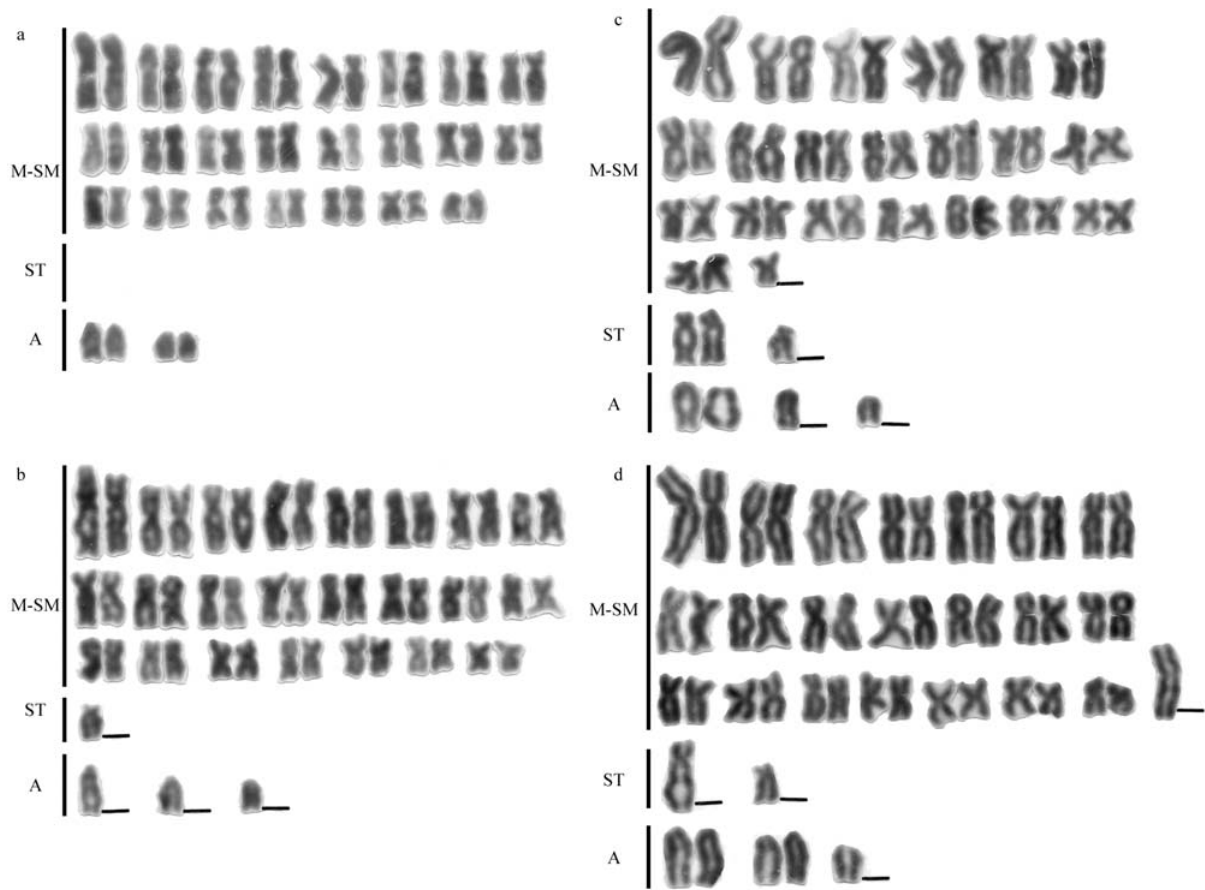
Figure2 -KaryotypesofPratariver Hoplerythrinusunitaeniatus with2n=50chromosomes,showingdistinctstructures(a-d).Thedashesindicateanap- parent lacking of